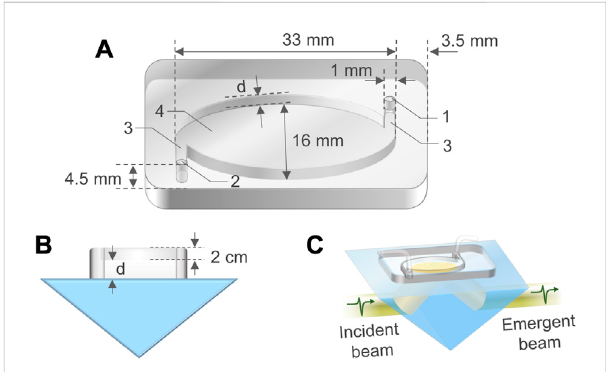
FIGURE 1 Con fi guration of a M-chip. (A) A 3D schematic view of a M-chip, in which the inlet “ 1 ” and outlet “ 2 ” holes, channels “ 3 ” , and cavity “ 4 ” are connected. The diameter of the holes is 1 mm. The cavity is in a shapeofellipticcylinder,withamajoraxislengthof33 mm,anda minor axis length of 16 mm. The distances between the holes and the chip outside edges are 3.5 mm along the major axis direction and 4.5 mm along the minor axis direction of the cavity, respectively. (B) SideviewofaM-chipsituated onan ATRprism.Thedepthofchannels isthesameas thecavity depth ( d ),whichisavariable. Thedepth ofthe holes is the summation of the cavity depth and the thickness (2 cm) of the upper wall. (C) A 3D schematic view of the ATR apparatus integrated with a M-chip. A p -polarized THz beam is incident horizontally to the left slanted side of the ATR prism, an isosceles triangulated column, then refracted and incident to the prism base at which the attenuated total internal re fl ection occurs. The emergent beam is detected for